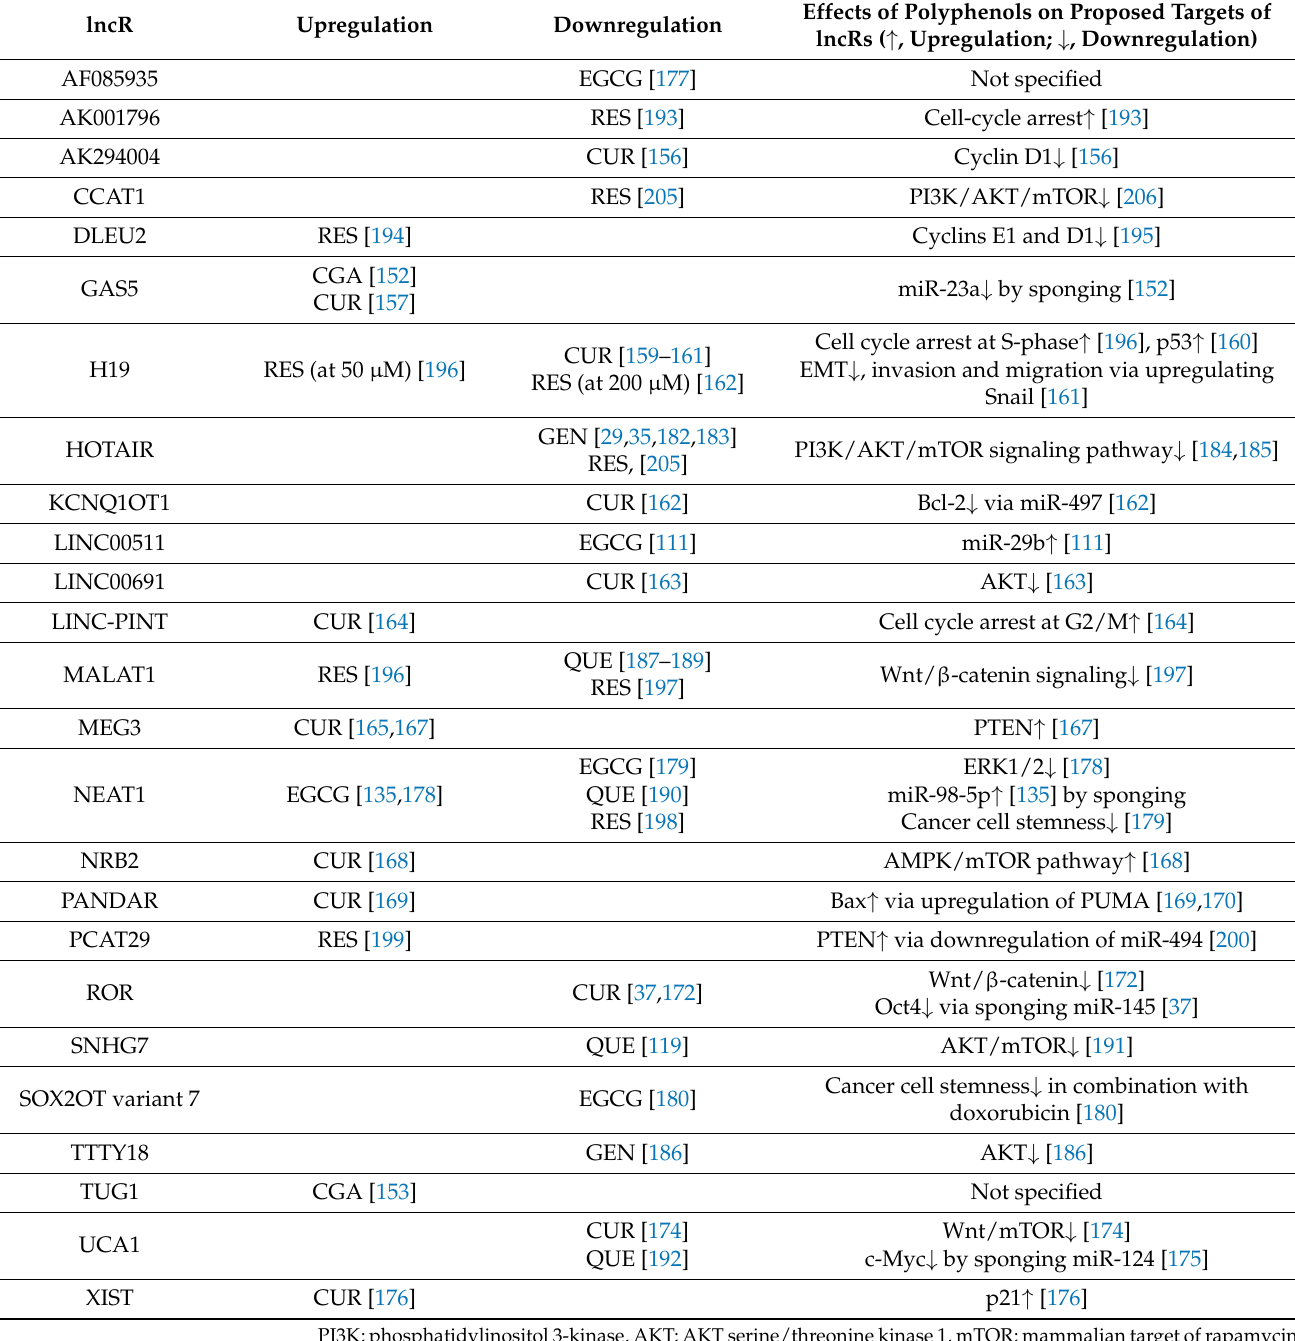
Table 5. Modulation of lncRs by six dietary polyphenols and targets affected by lncRs. Effects of Polyphenols on Proposed Targets of lncRs ( ↑ , Upregulation; ↓ ,